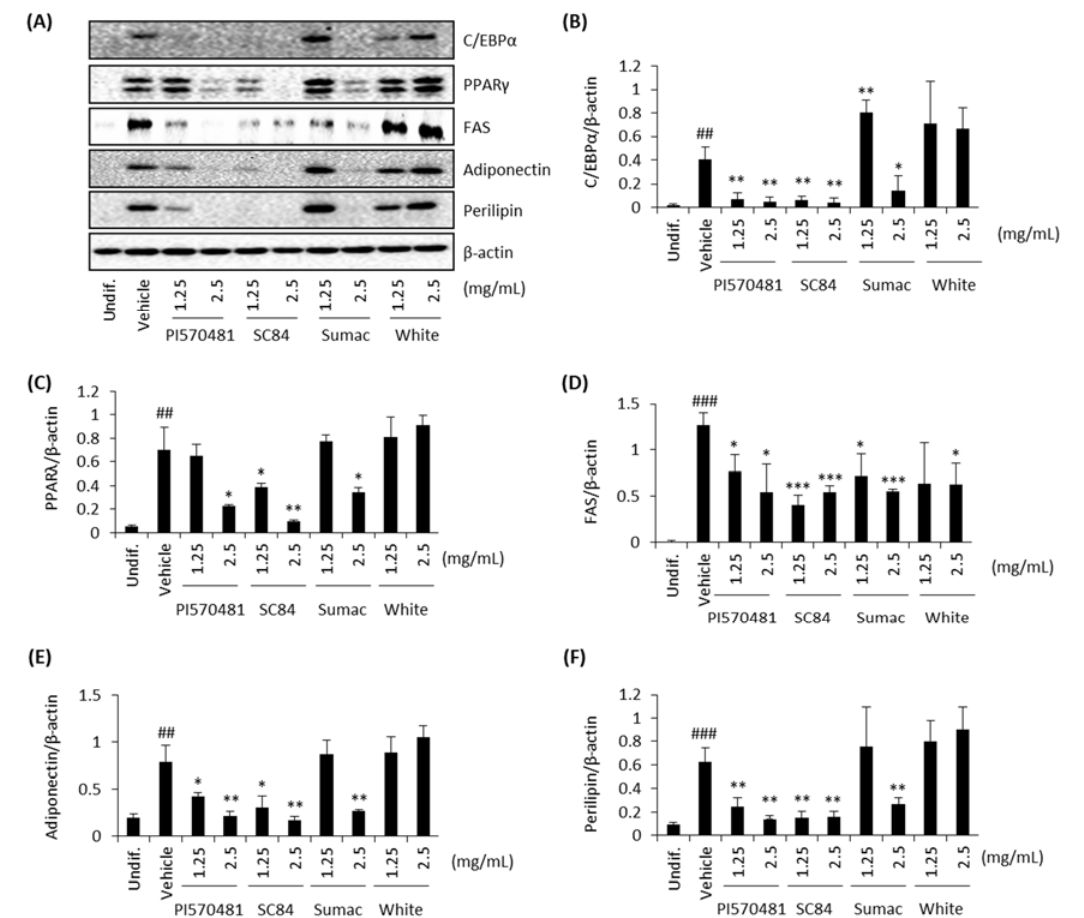
Figure 4. Sorghum bran extracts repressed expression of adipogenic and lipogenic proteins in differentiated 3T3-L1 cells. 3T3-L1 cells were treated with 0, 1.25, and 2.5 mg/mL sorghum extracts (PI570481, SC84, Sumac, white) for 10 days and Western blot was performed for C/EBP α , PPAR γ , FAS, adiponectin, perilipin, and β -actin. ( A ) Representative western blot images ( B – F ) Densitometry data generated for Western blots. Values are means ± SD ( n = 3). Significance is indicated as # and *. ## p < 0.01, ### p < 0.001 as compared to control (undifferentiated cells). * p < 0.05, ** p < 0.01, *** p < 0.001 as compared to untreated (0 mg/mL) differentiated cells.